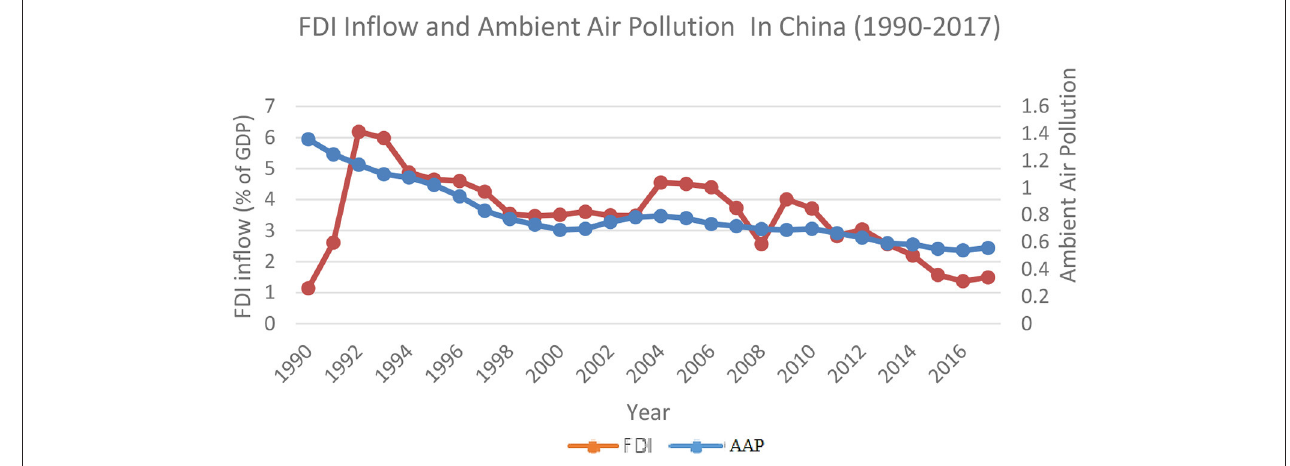
FIGURE 1 | Foreign direct investment (FDI) inflow and ambient air